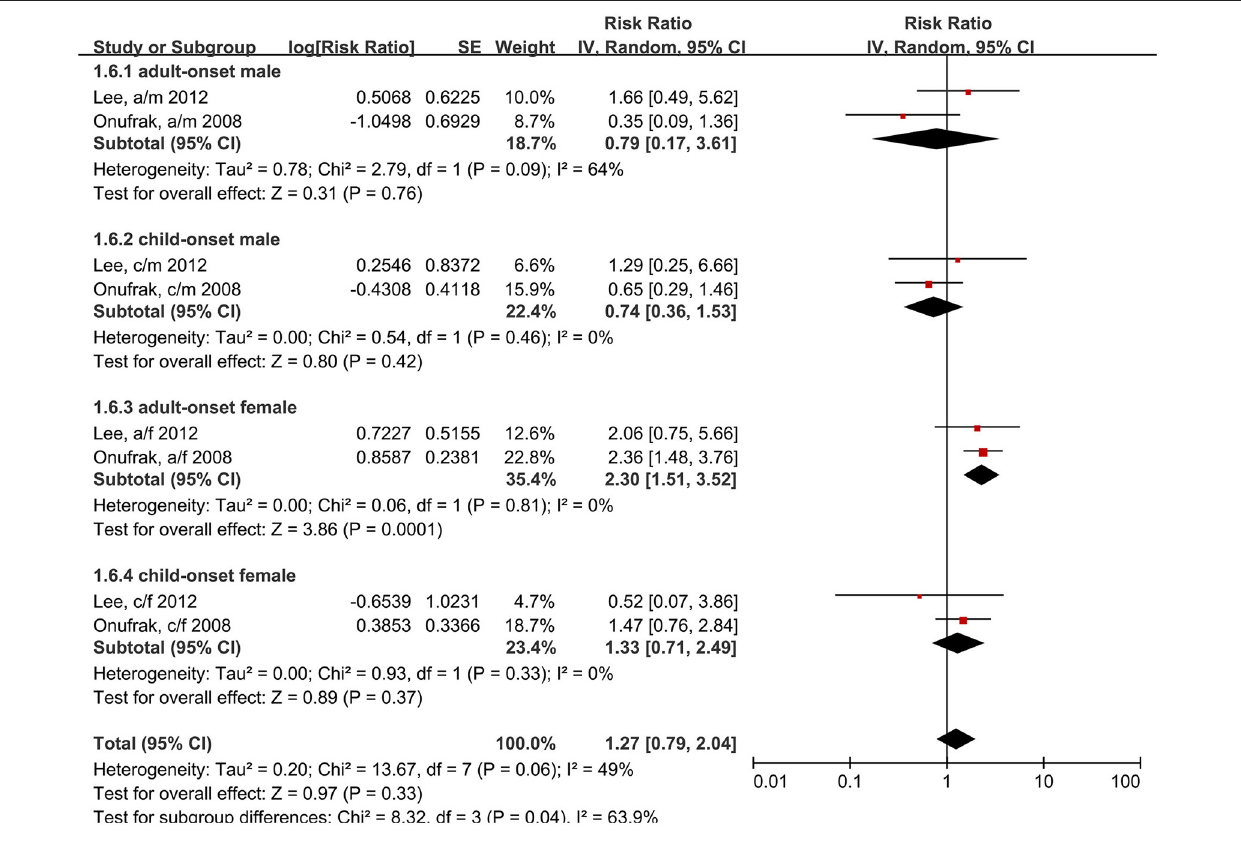
Frontiers in Neurology |